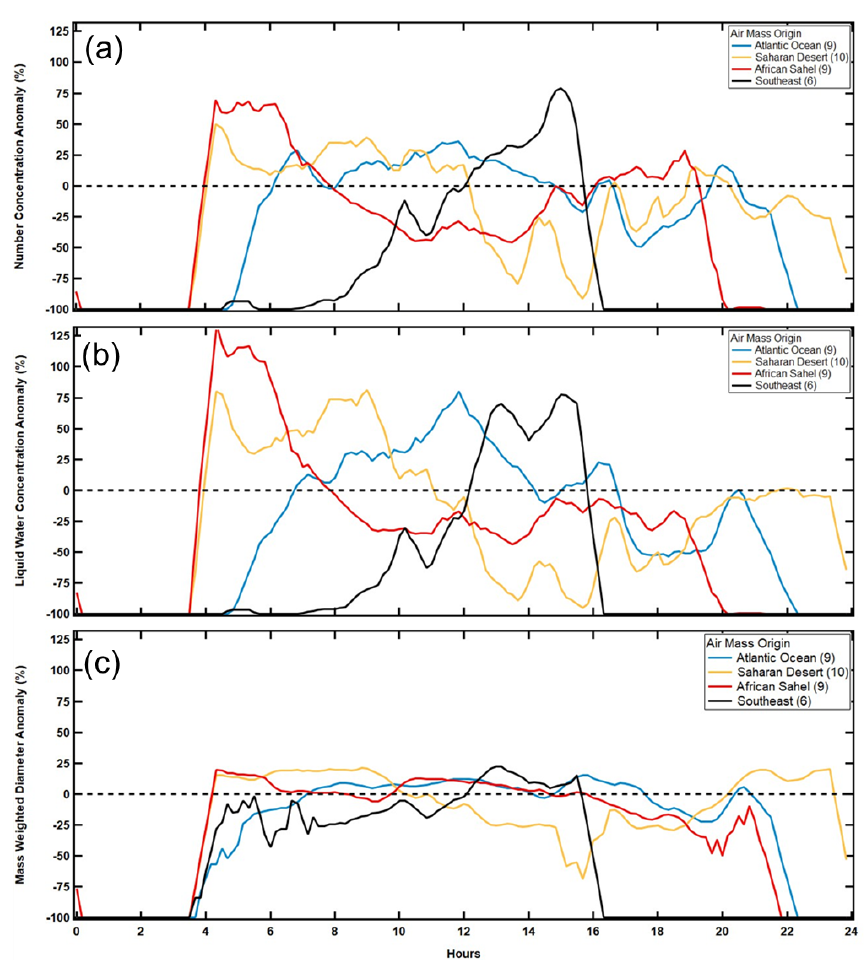
Figure 7. The deviations in (a) number concentration, (b) LWC, and (c) MVD from their average values over the time period of air mass intrusion are summarized in these figures for air mass types, in percent